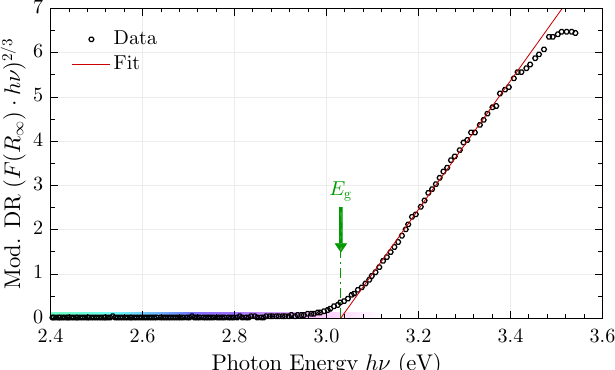
Figure 12. Tauc plot of the non-contaminated rutile-TiO 2 (circles, cf. Figure 7a) and corresponding linear fit (solid line) for determination of the band gap E g